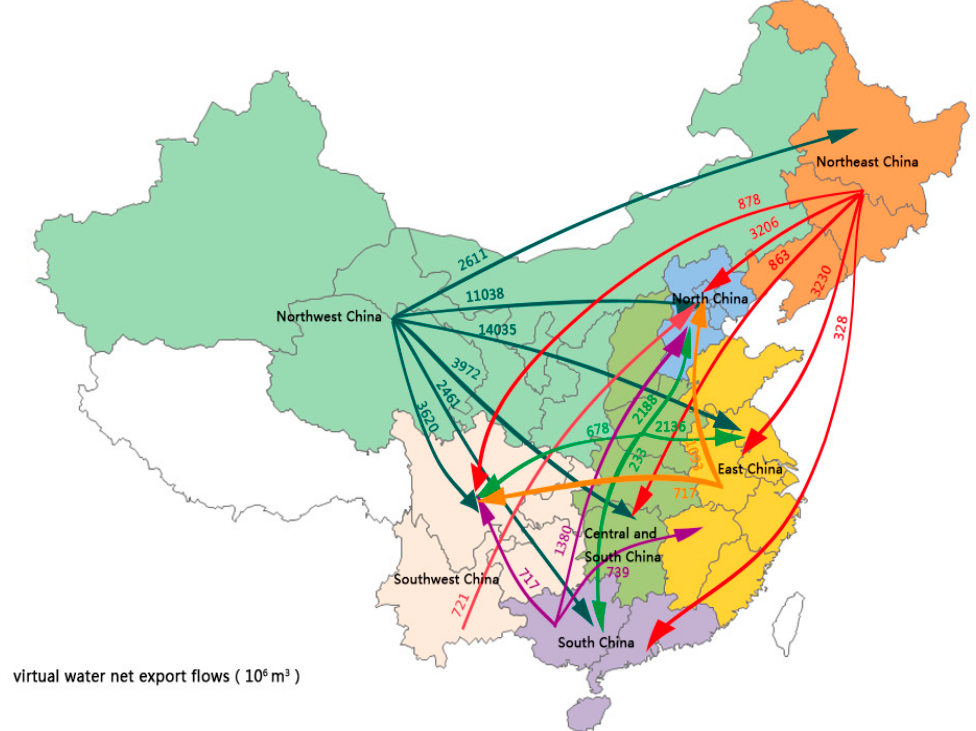
Figure 2. Detailed volumetric agricultural virtual water net export flows.